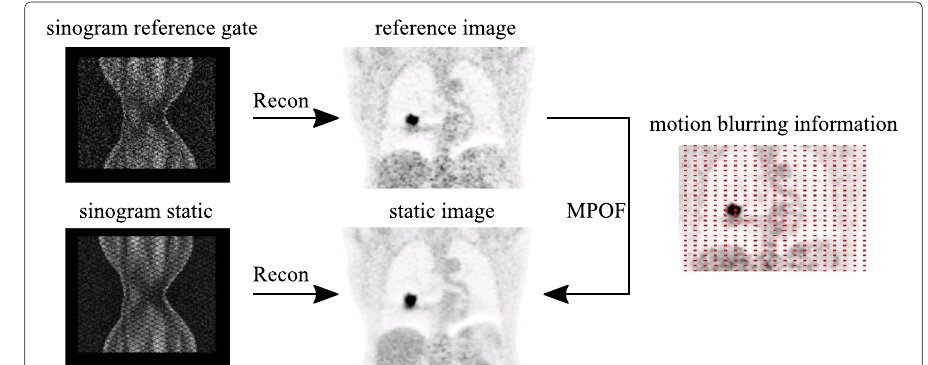
Fig. 3 Motion correction using motion deblurring (DEB-MC)